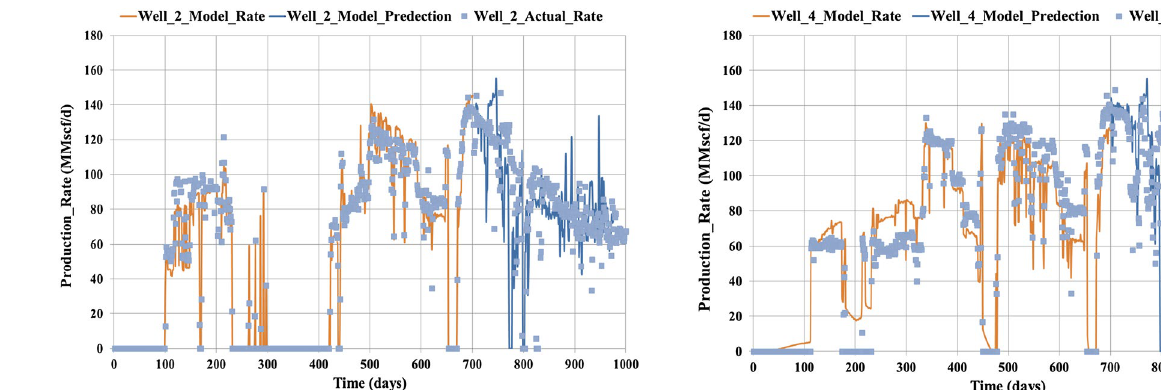
Fig. 6 Well 3 rate history match and prediction (case 1)